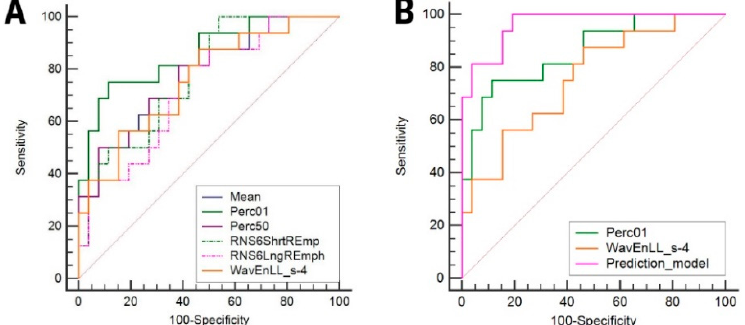
Figure 3. Comparison of receiver operating characteristic (ROC) curves between ( A ) the six texture parameters that showed the highest area under the curve, and ( B ) independent parameters and the predictive model for the diagnosis of high-grade gliomas. Mean, histogram mean; Perc01/50, 1%/50% percentile; ShrtREmp, short-run emphasis; LngREmph, long-run emphasis; WavEn, wavelet energy.